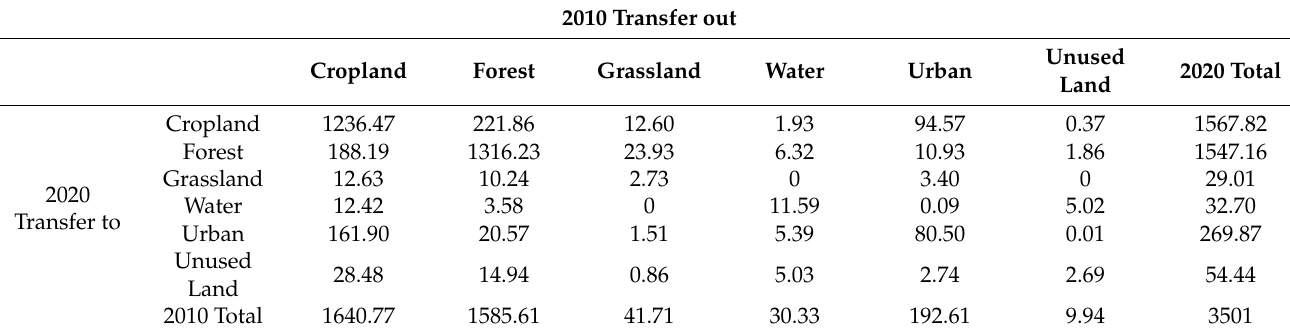
Table 8. Land Use Transfer Matrix 2010~2020 (km 2